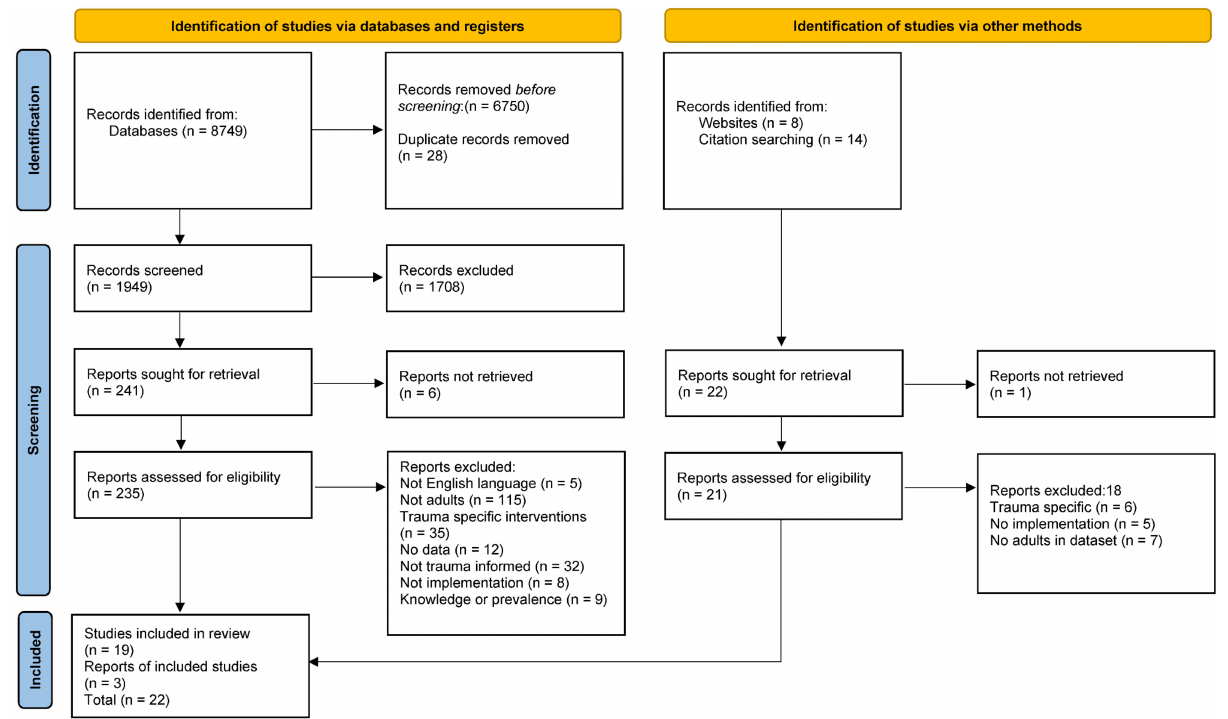
Figure 1. The flow of information through the different phases of the scoping review and the rationale for